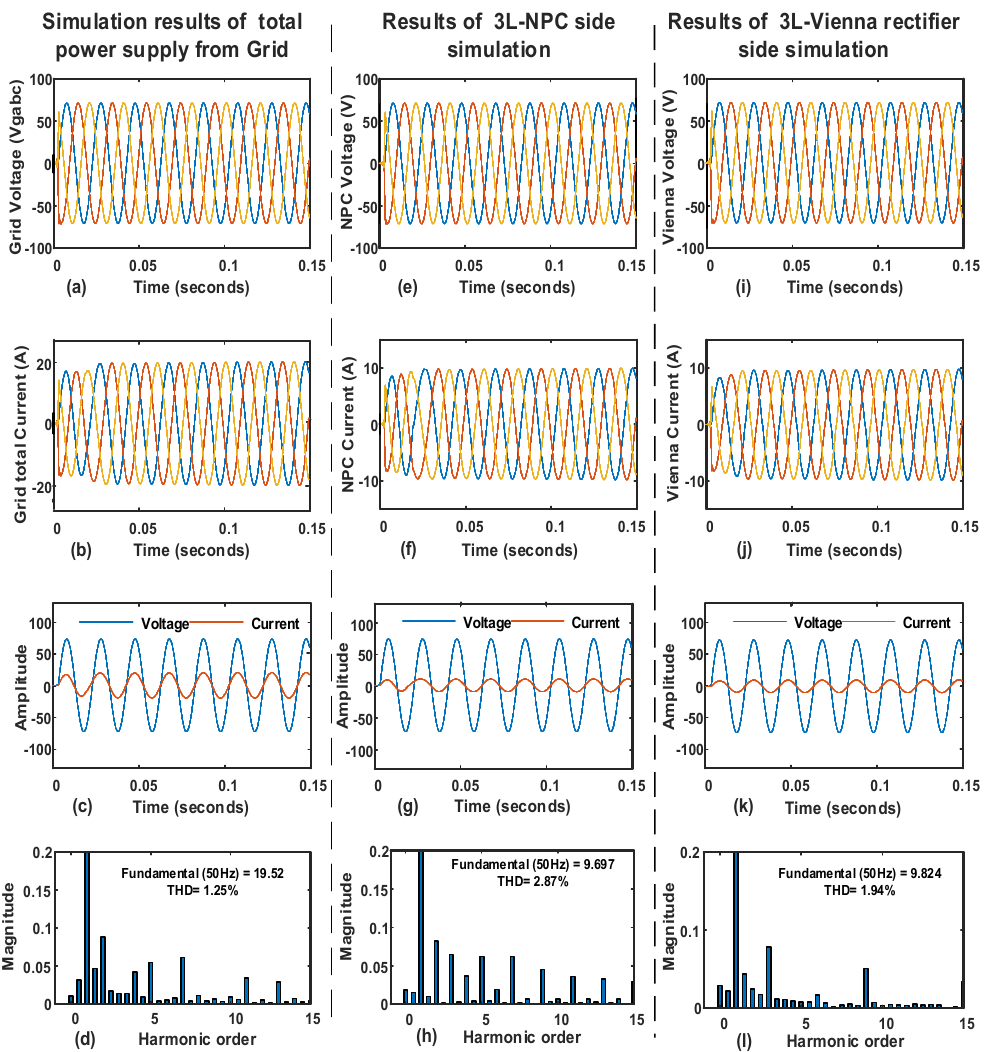
Figure 6. Simulation results of a 2-KW proposed hybrid converter.